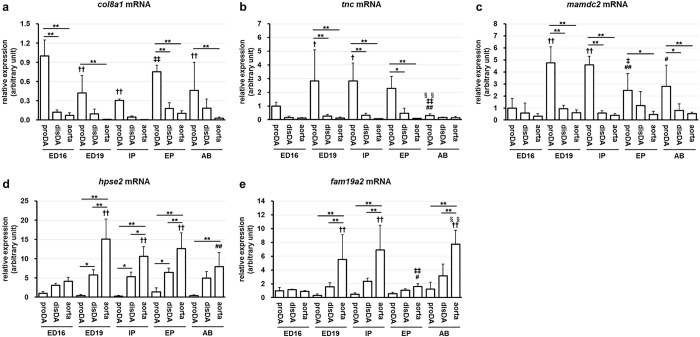
Quantitative PCR analysis for proximal DA-enriched or aorta-enriched genes.The relative mRNA levels of col8a1 (a), tnc (b), mamdc2 (c), hpse2 (d) or fam19a2 (e) to gapdh were quantified by RT-PCR. * and ** indicate p < 0.05 and p<0.01, † and †† indicate p < 0.05 and p<0.01 compared to the same tissues of the ED16 stage, # and ## indicate p < 0.05 and p<0.01 compared to the same tissues of the ED19 stage, ‡ and ‡‡ indicate p < 0.05 and p<0.01 compared to the same tissues of the IP stage, §§ indicates p<0.01 compared to the same tissues of the EP stage, n = 5–6.